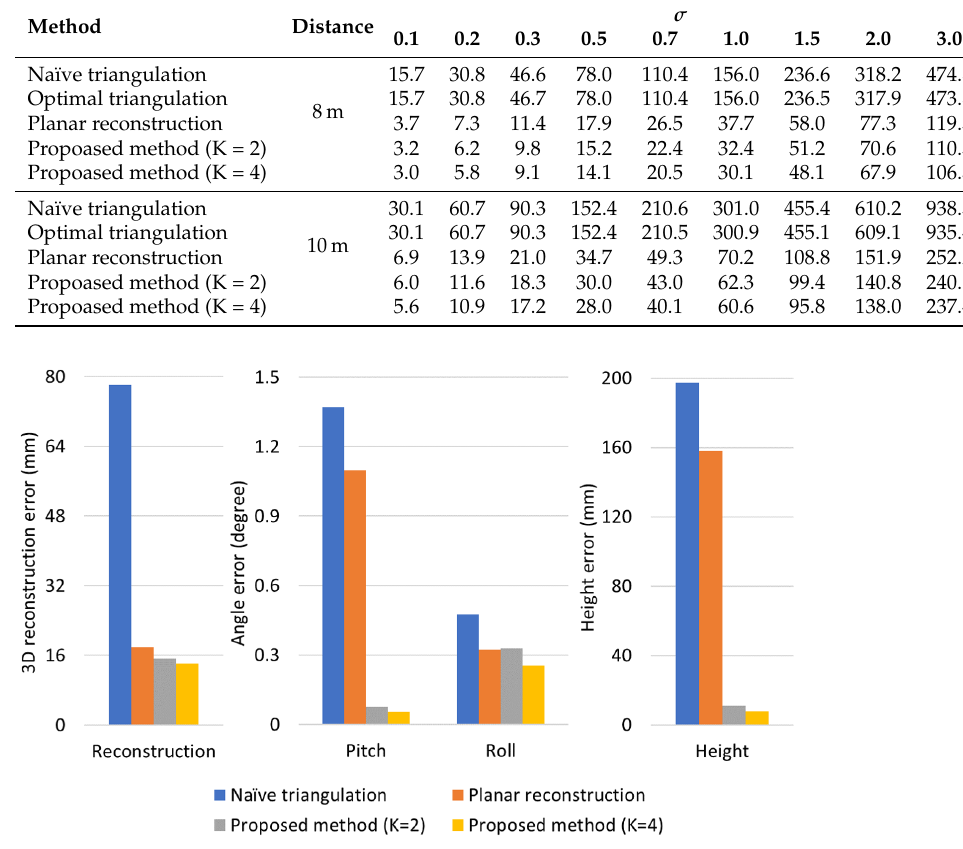
Figure 4. Reconstruction and calibration errors in simulation